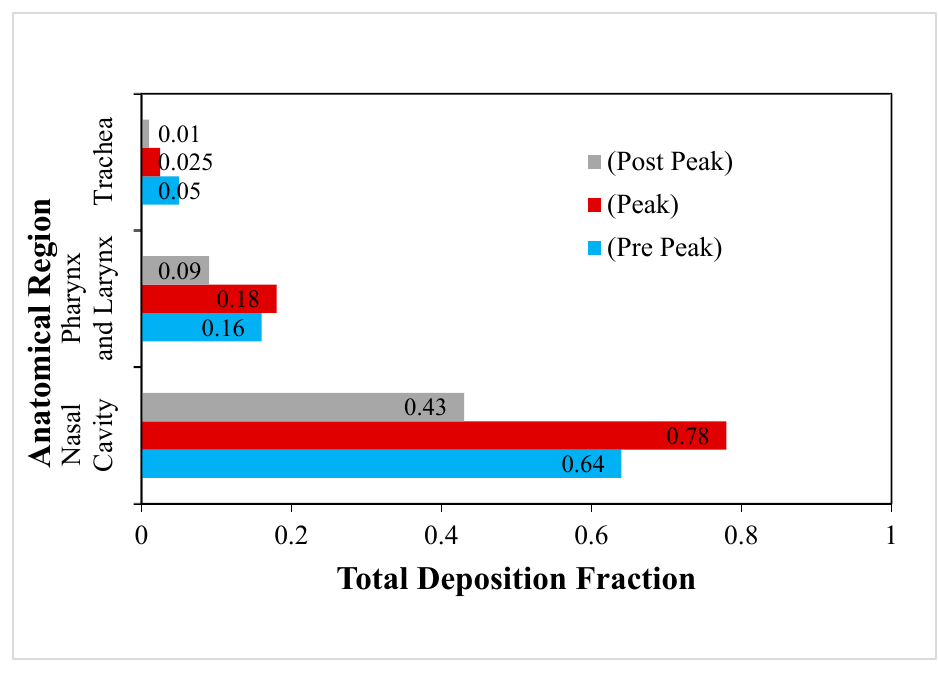
Figure 7. Regional deposition fraction (RDF) of RSPM in the upper airways at moderate inhalation.